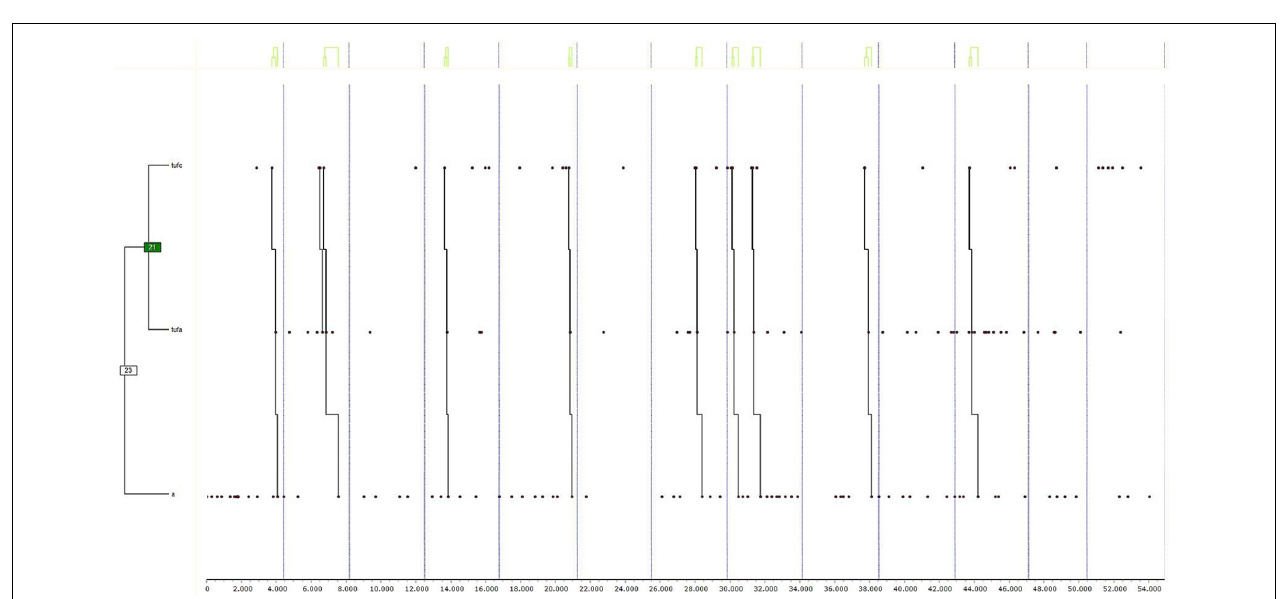
FIGURE 4 | Dendogram obtained from THEME belonging to group “2” exclusively in girls. The decisional categories of the mixed registration system ( Table 1 ) were used for searching for T-patterns.